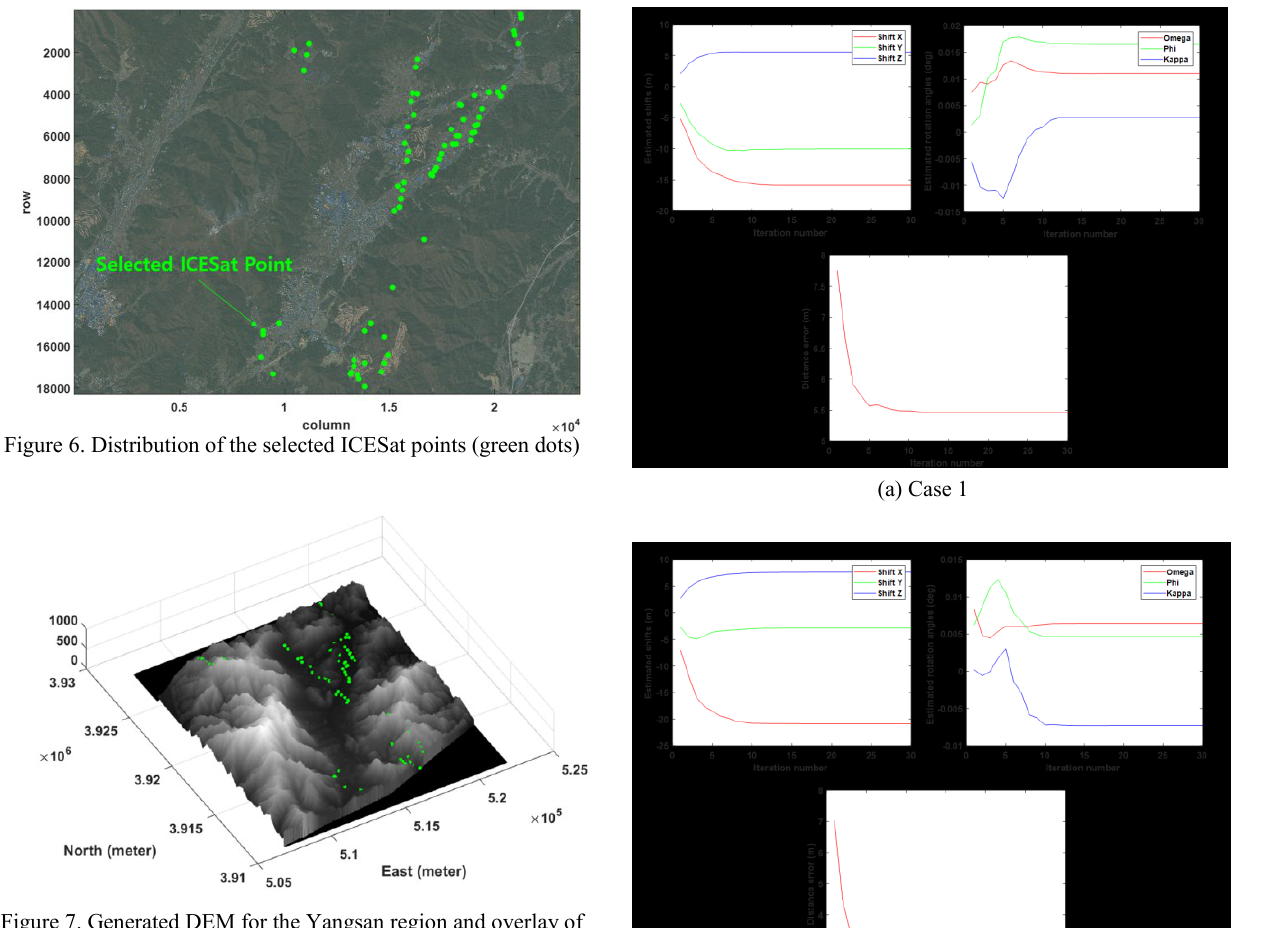
Figure 7. Generated DEM for the Yangsan region and overlay of the selected ICESat points (green dots)